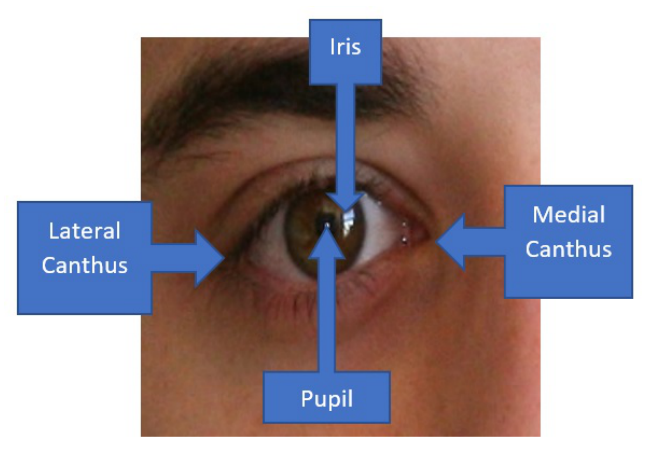
Figure 1. Medial canthus and lateral canthus of the eye.